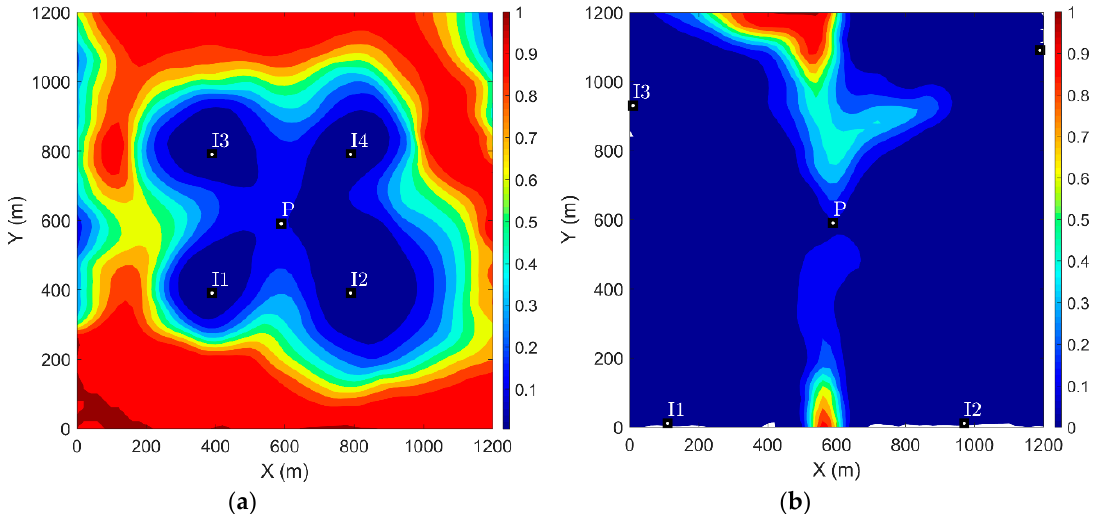
Figure 8. Injection wells capture zones for the ( a ) initial and ( b ) optimal well designs in the two- dimensional heterogeneous aquifer.